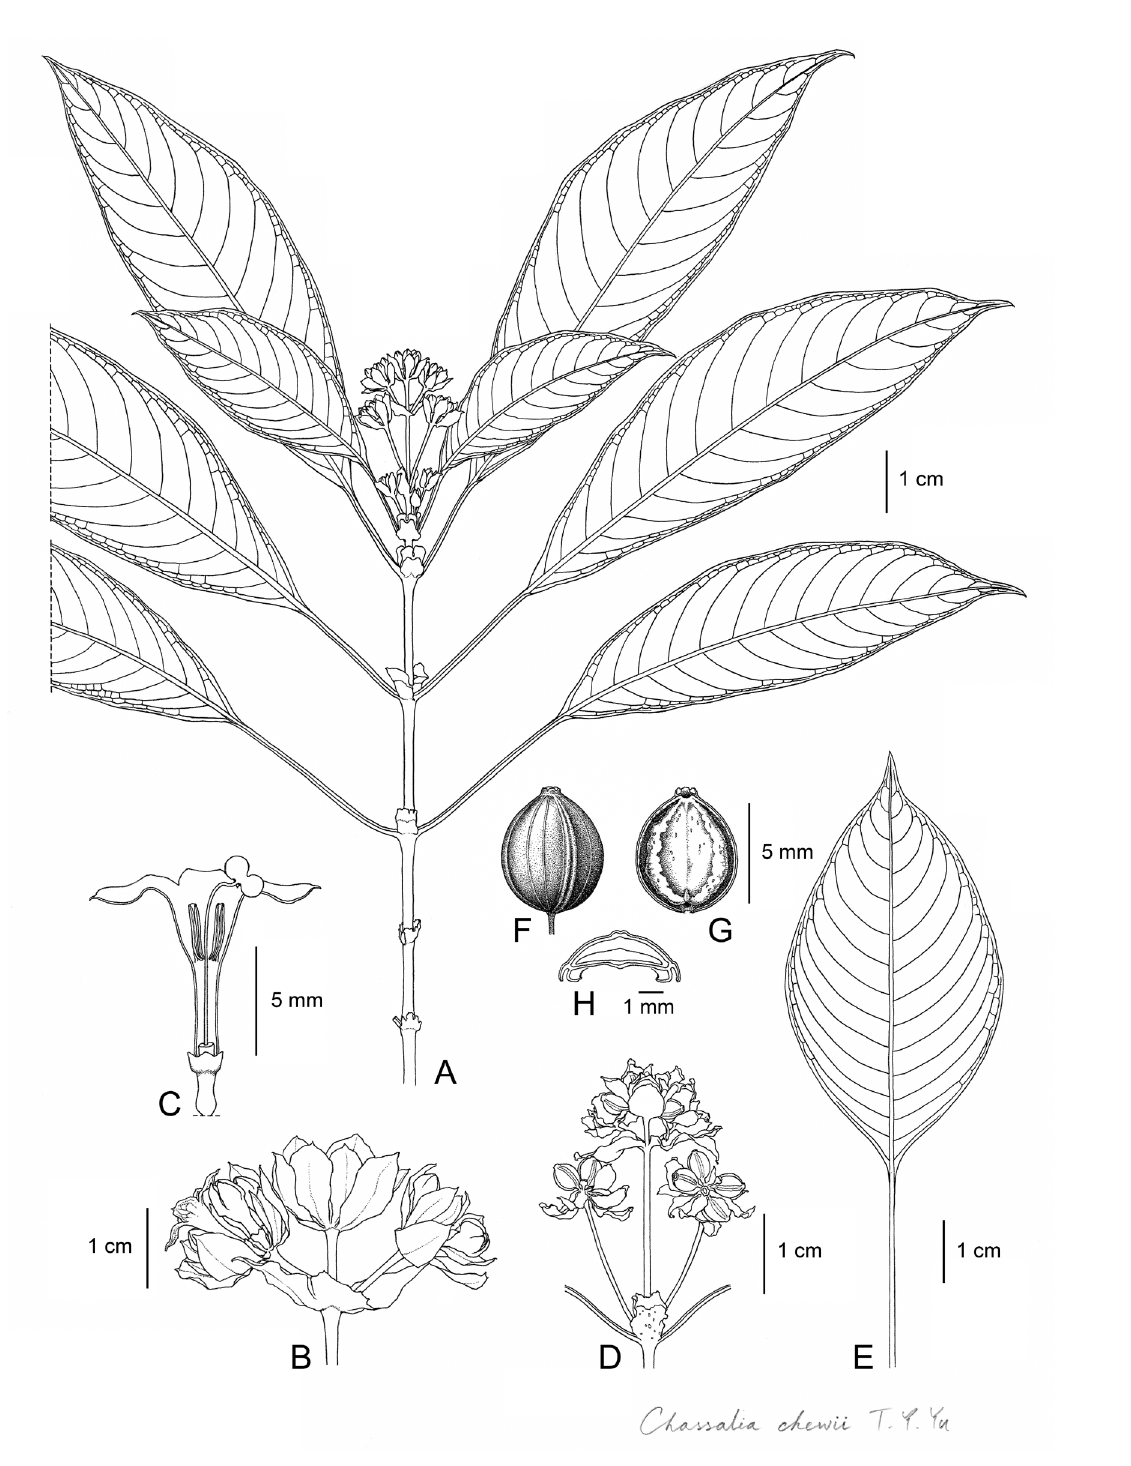
Fig. 10. Chassalia chewii T.Y.Yu sp. nov. A . Flowering shoot. B . Inflorescence showing capitulum, bracts and flowers. C . Longitudinal view of flower showing stamens, band of hairs, stigma, style, disc, calyx and hypanthium. D . Infructescences. E . Leaf showing another shape of leaf-blade. F . Dry fruit. G . Pyrene ventral surface. H . Pyrene transection. A–C from W.L. Chew, E.J.H. Corner & A. Stainton 1226 ; D–H from J & M.S. Clemens 30335 . Drawn by T.Y.